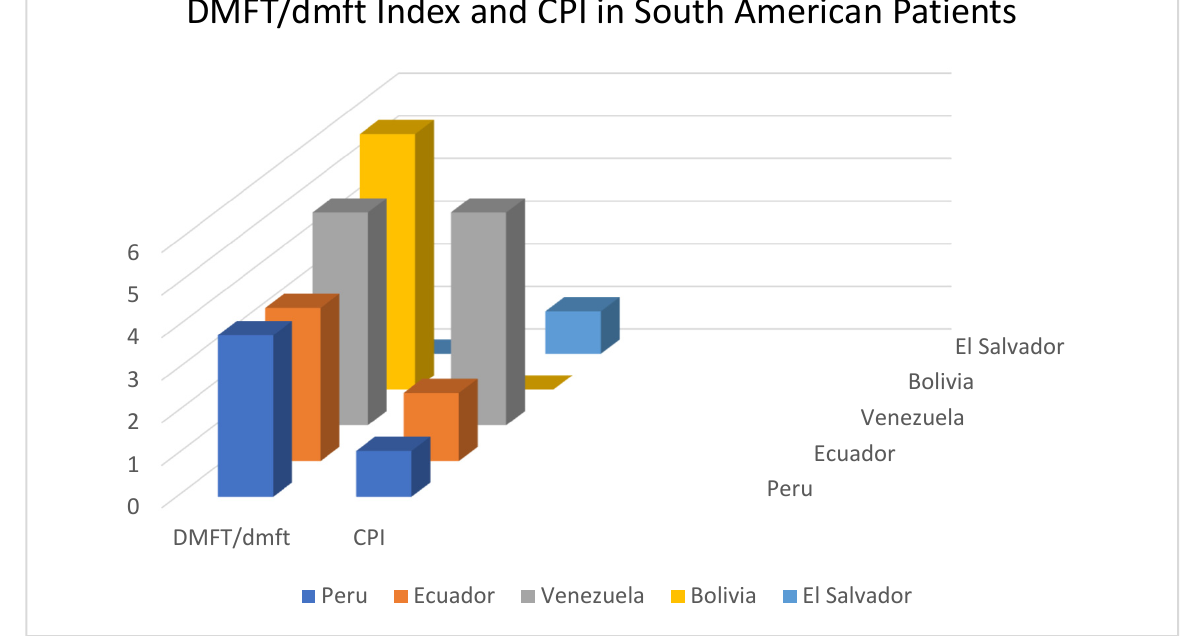
Figure 2. DMFT/dmft Index and CPI (means) in Central and South American patients.